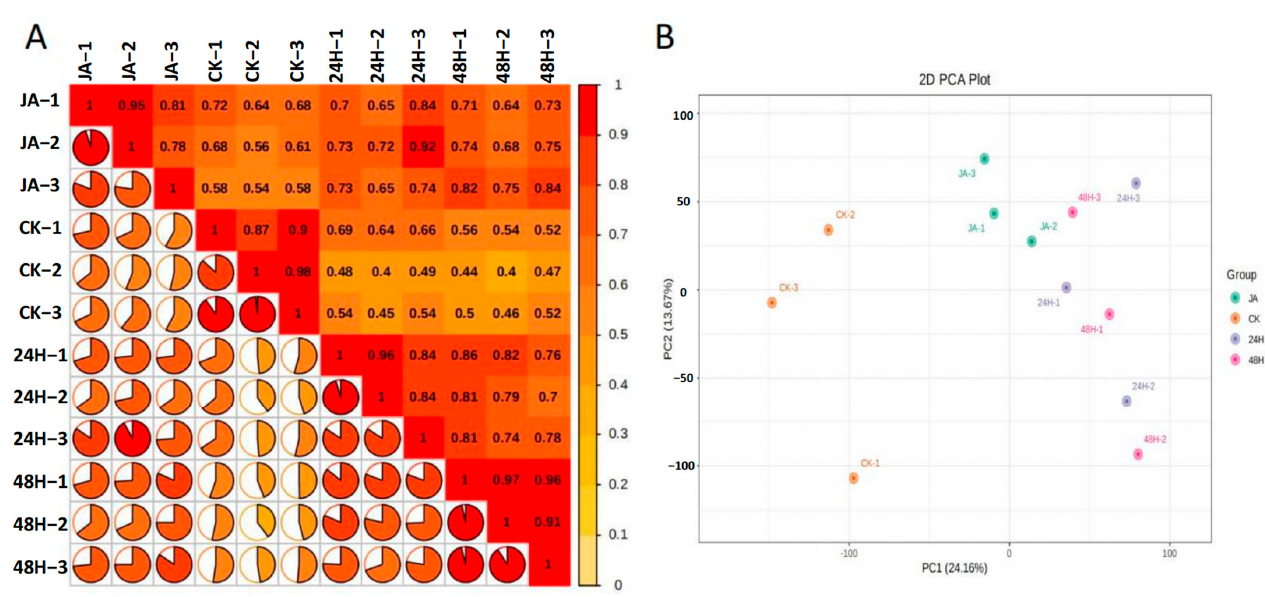
Figure 1. ( A ) Isoform length distribution diagram. ( B ) Transcript annotated statistical chart.